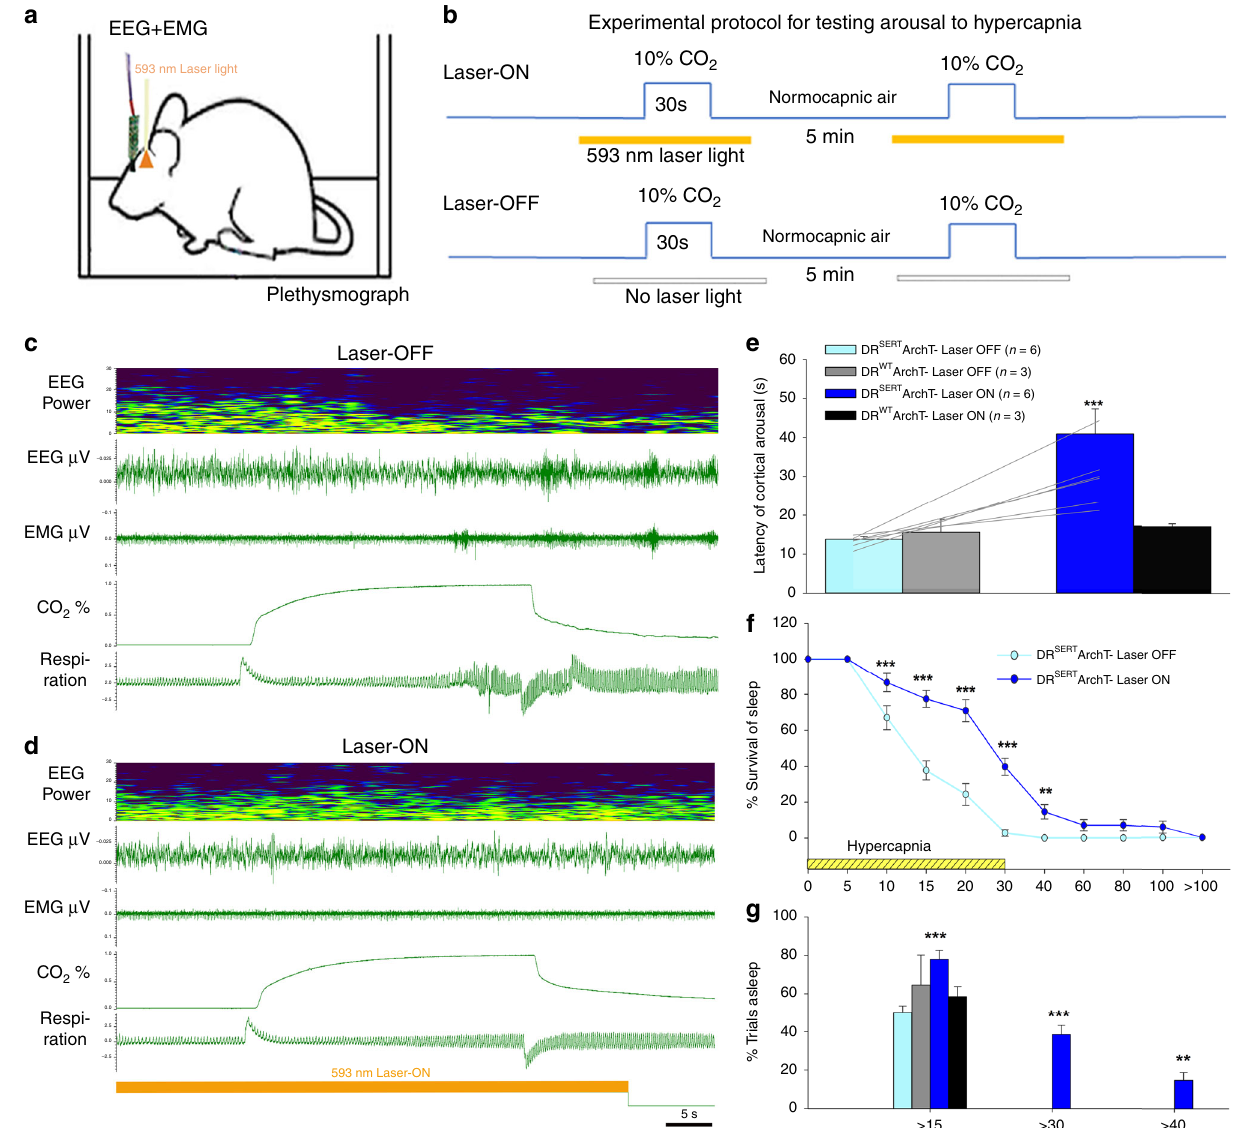
Fig. 5 Optogenetic silencing of the DR Sert neurons acutely prevents hypercapnia-induced arousal. Schematic of a mouse ( a ) implanted with EEG/EMG and glass fi ber targeting the DR in the experimental protocol to test CO 2 arousal, as shown in b . The 593 nm laser is on for 20 sec before and 10 sec after each 30 sec period of CO 2 stimulation during the Laser-ON condition. Panels c , d show the EEG power spectrum, EEG, EMG, CO 2 level in the chamber, and respiration during representative trials of CO 2 exposure in Laser-OFF ( c ) and Laser-ON ( d ) conditions. The mouse awoke in 17 sec in response to the rising CO 2 during Laser-OFF in c , as demonstrated by desynchronization of the EEG (decrease of power in lower frequencies; shown in top two traces), increase in EMG (third trace) and sudden increase in the rate and volume of ventilation at the time of EEG arousal (lower trace) in c . With Laser-ON ( d ), the mouse did not wake up to the CO 2 stimulus as can be seen by the presence of synchronized EEG, and minimal EMG activity, during the steadily increasing respiration in response to CO 2 (there are brief artifacts in the plethysmograph air fl ow trace at the shift in gas mixtures). Panels e – g show graphically the effect of acute silencing of the DR Sert neurons on the latency of CO 2 arousal (mean ± SEM) ( e ) in Laser-OFF and Laser-ON conditions (DR Sert ArchT, n = 6; DR WT ArchT, n = 3), and the mice in the DR Sert group are shown using line graphs in both Laser conditions. The survival curves ( f ) show the reduction in arousal (mean ± SEM) across the CO 2 exposure. Panel g shows that ~40% of the mice with silencing of DR Sert neurons did not awaken within 30 sec (F 3,14 = 49.41, P < 0.001) of onset of CO 2 exposure, whereas without the laser the same mice woke up in every trial, and these were statistically compared using the one-way ANOVA followed by multiple comparisons for treatment groups. Data in e – g are presented as mean values ± SEM. ** P < 0.01; *** P < 0.001; one-way ( e , g ) or two-way ANOVA ( f